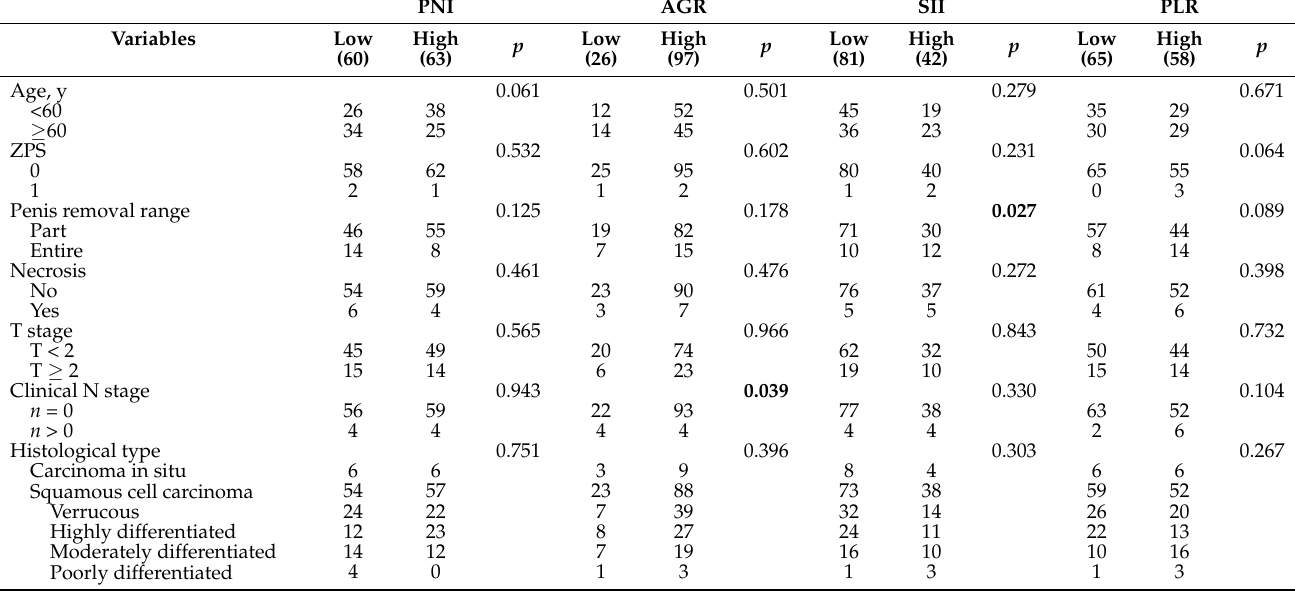
ZPS: Performance Status Zubrod-ECOG-WHO. Bold values indicate the statistically significant p values ( p ≤ 0.05).